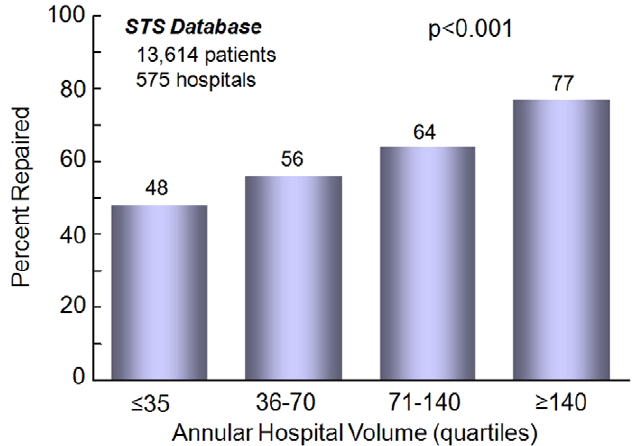
Figure. 4 Rates of mitral valve repair for primary mitral regurgitation in the Society of Thoracic Surgeons (STS) Database related to hospital volume of mitral valve surgery. Patients undergoing surgery for MR at higher volume centers were significantly more likely to receive mitral valve repair rather than mitral valve replacement, compared to those undergoing surgery at lower volume centers. Reproduced from Gammie et al. [19] with